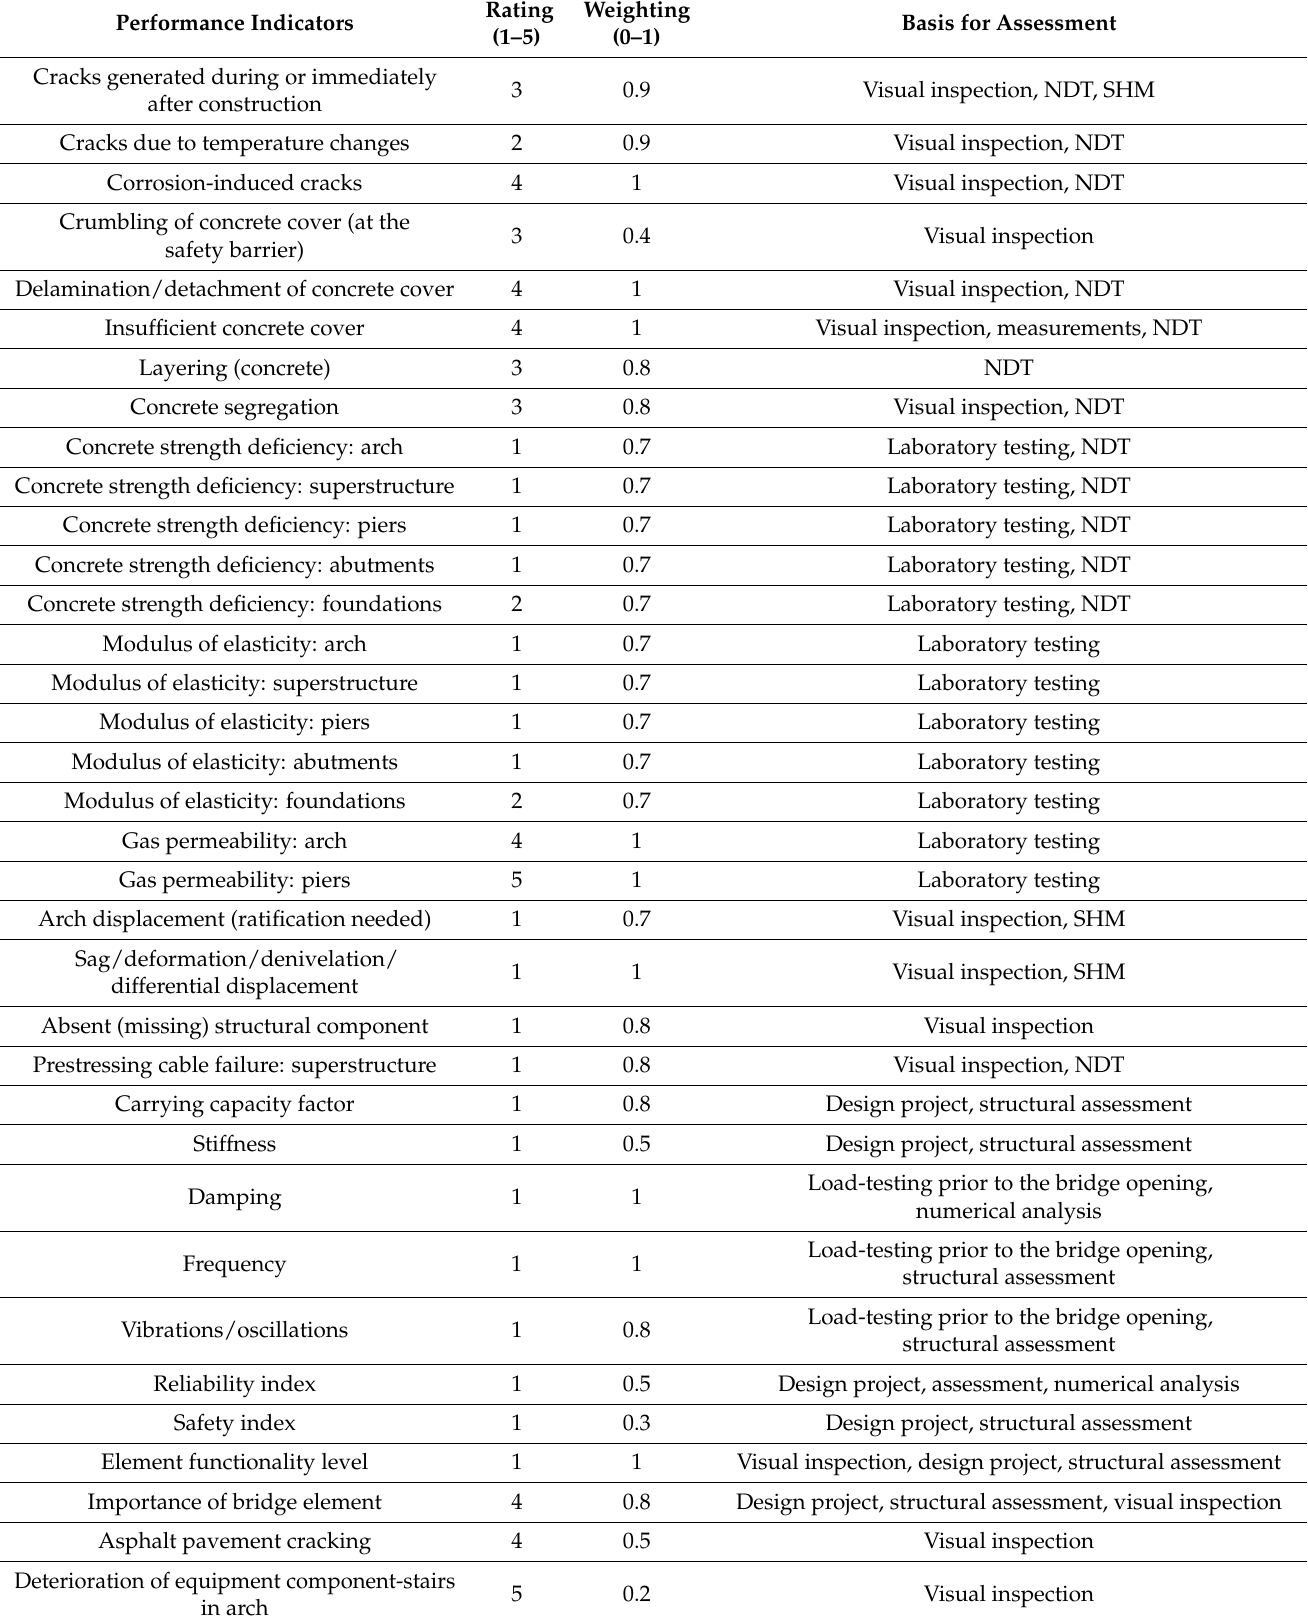
Table 8. Assessment of key performance indicators related to safety, reliability, and